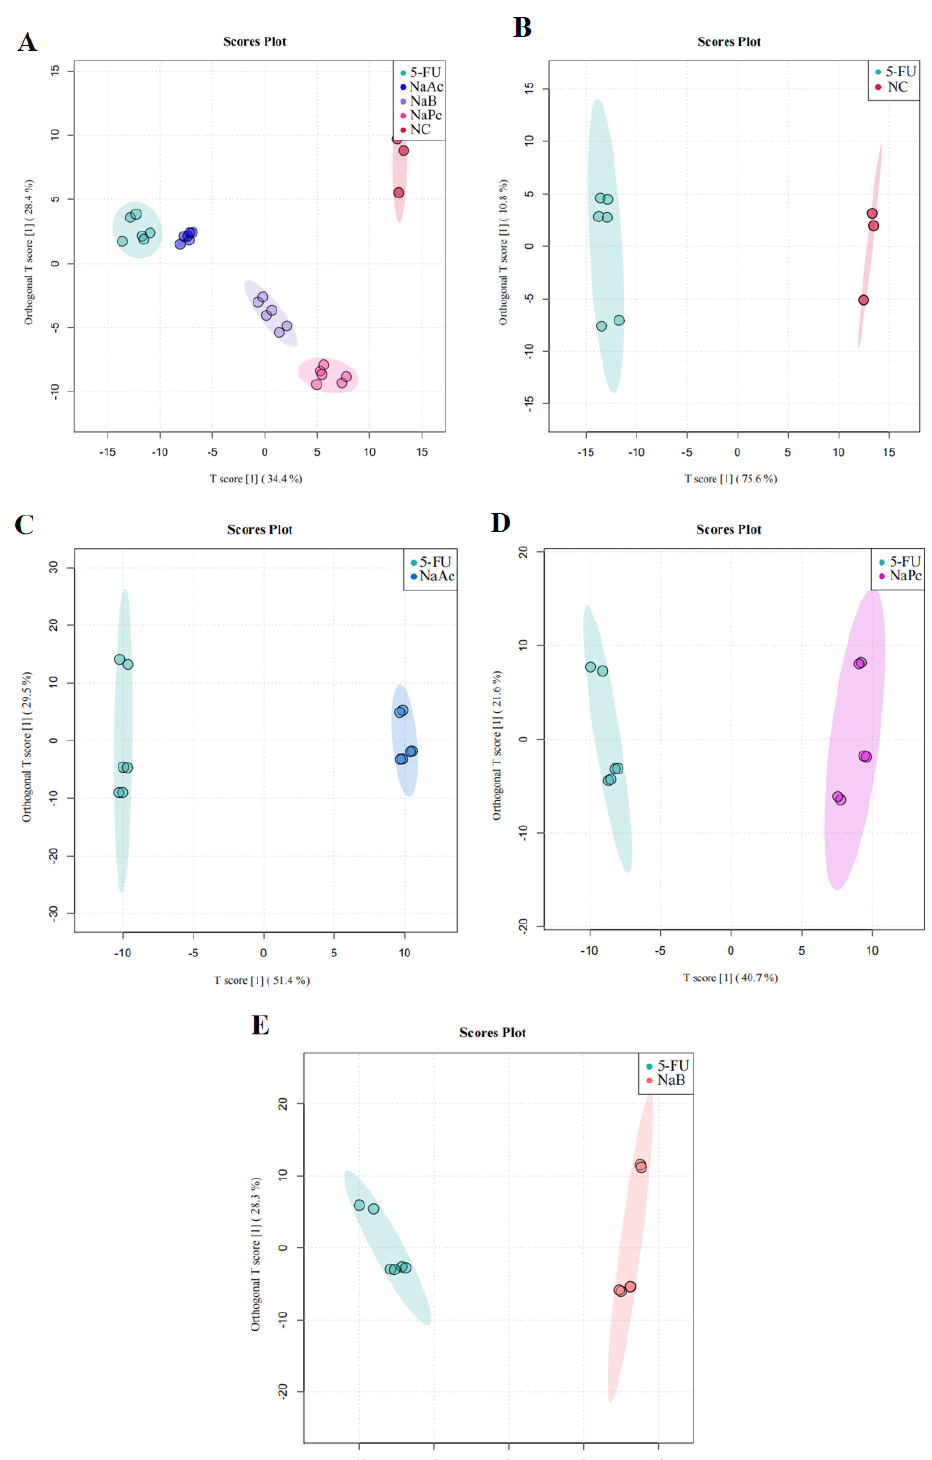
Figure 6. OPLS − DA score plot in the positive ion mode analysis for the effects of SCFAs on cellular metabolites ( n = 6/group). ( A ): OPLS − DA score plot analysis in all groups; ( B ): OPLS − DA score plot analysis for the NC and 5 − FU group; ( C ): OPLS − DA score plot analysis for the NaAc and 5 − FU group; ( D ): OPLS − DA score plot analysis for the NaPc and 5 − FU group; and ( E ): OPLS − DA score plot analysis for the NaB and 5 − FU group.